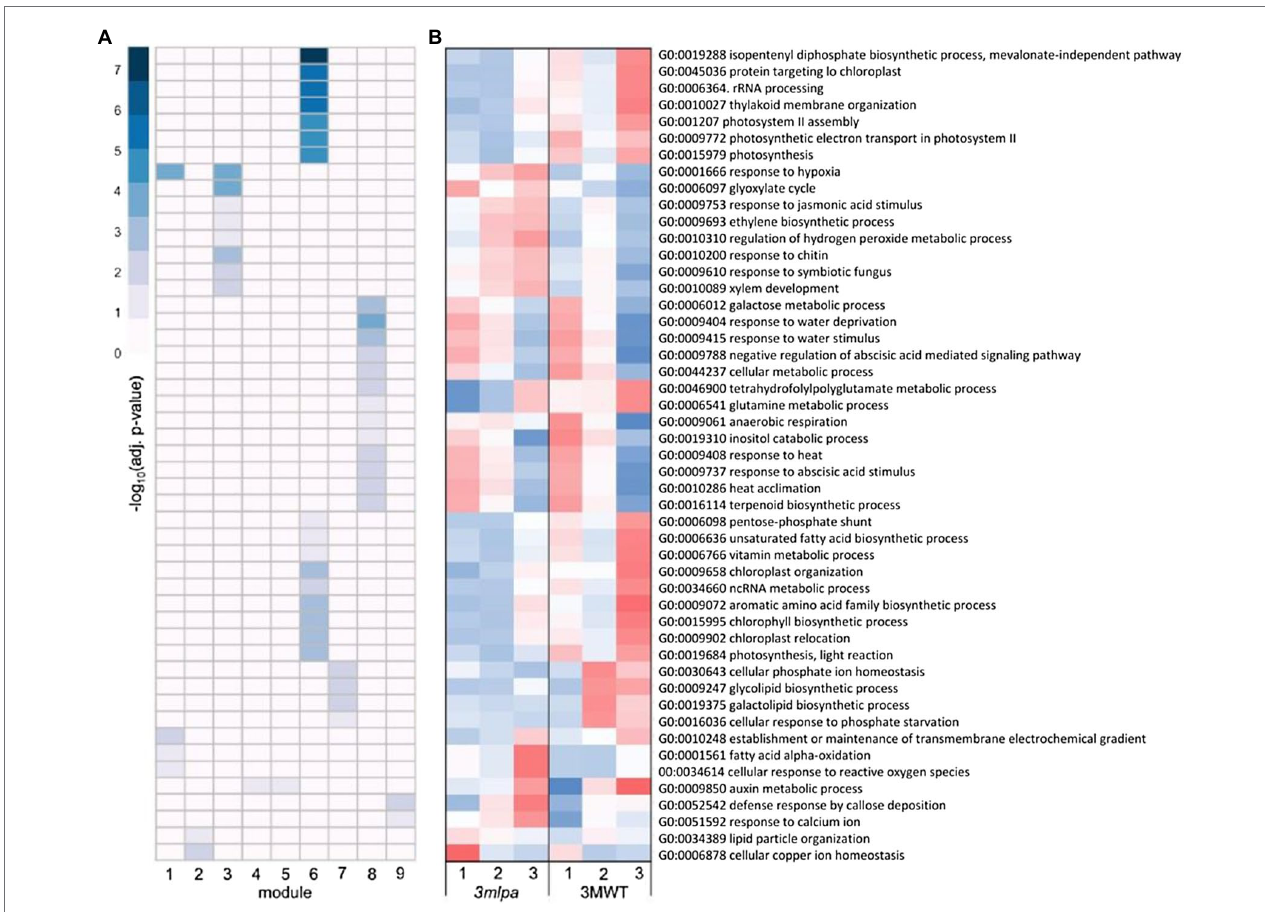
FIGURE 4 | Mips-MRP subset gene co-expression modules and significantly enriched biological processes. A module is defined as a group of genes sharing similar expression profiles over time and likely involved in the same biological processes. Rows represent hierarchical clustering of significantly enriched GO categories. Significantly enriched GO categories were defined as those with an FDR < 0.05. (A) Heatmap of significantly enriched GO biological processes in each gene co-expression module. Columns represent modules. Color represents − log 10 adjusted value of p . (B) Average scaled expression of genes in significantly enriched biological processes. Columns represent germination stages of 3mlpa and 3MWT. Red color represents increased expression, and blue color represents decreased expression. Enrichment for all GO categories can be found in Supplementary Table S2